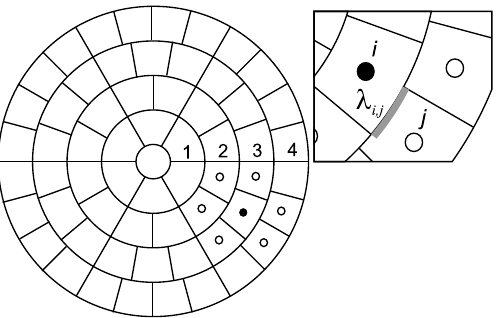
Fig. 1. The galaxy disk model subdivided into cells. The neighboring cells (open circles) to a cell under consideration (filled circle) and the fraction of its perimeter ( (cid:21) i;j ) contacting with a particular neighbor are